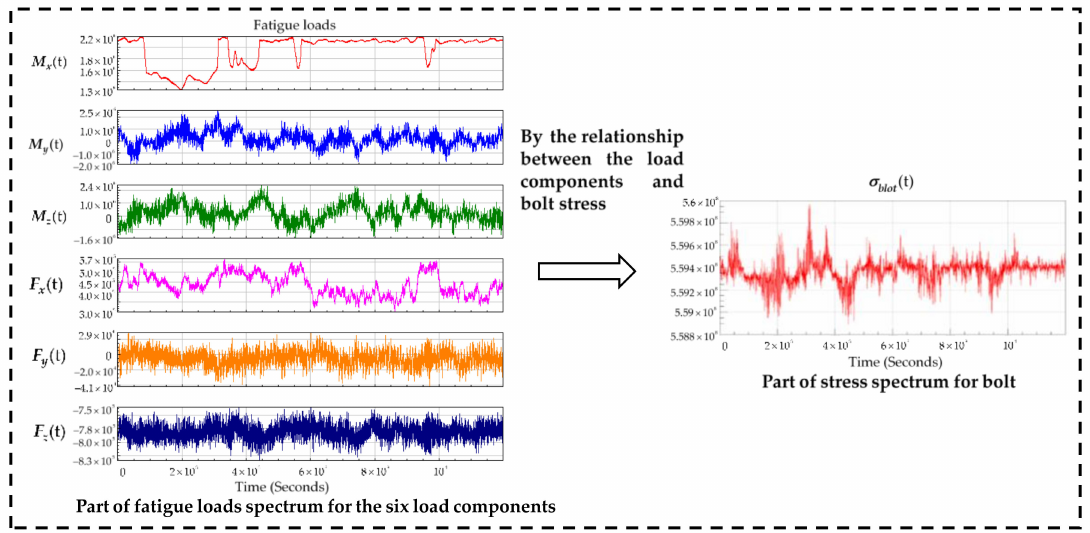
Figure 10. Part of stress spectrum for